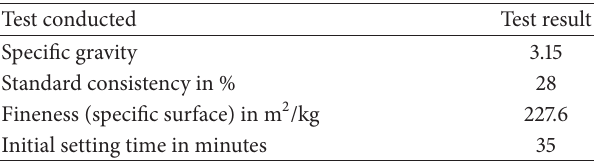
Table 1: Properties of cement.